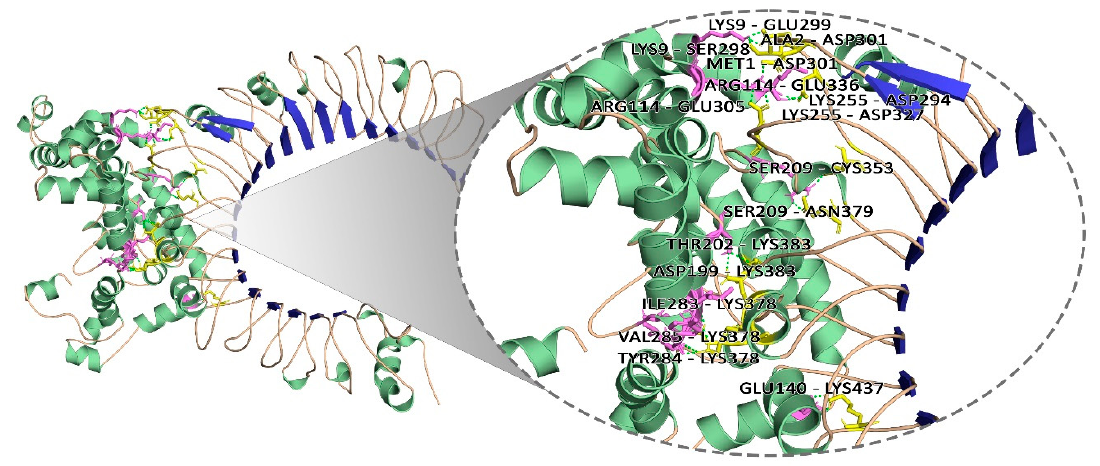
Figure 7. Molecular interaction of multi-epitope vaccine constructs with TLR2.